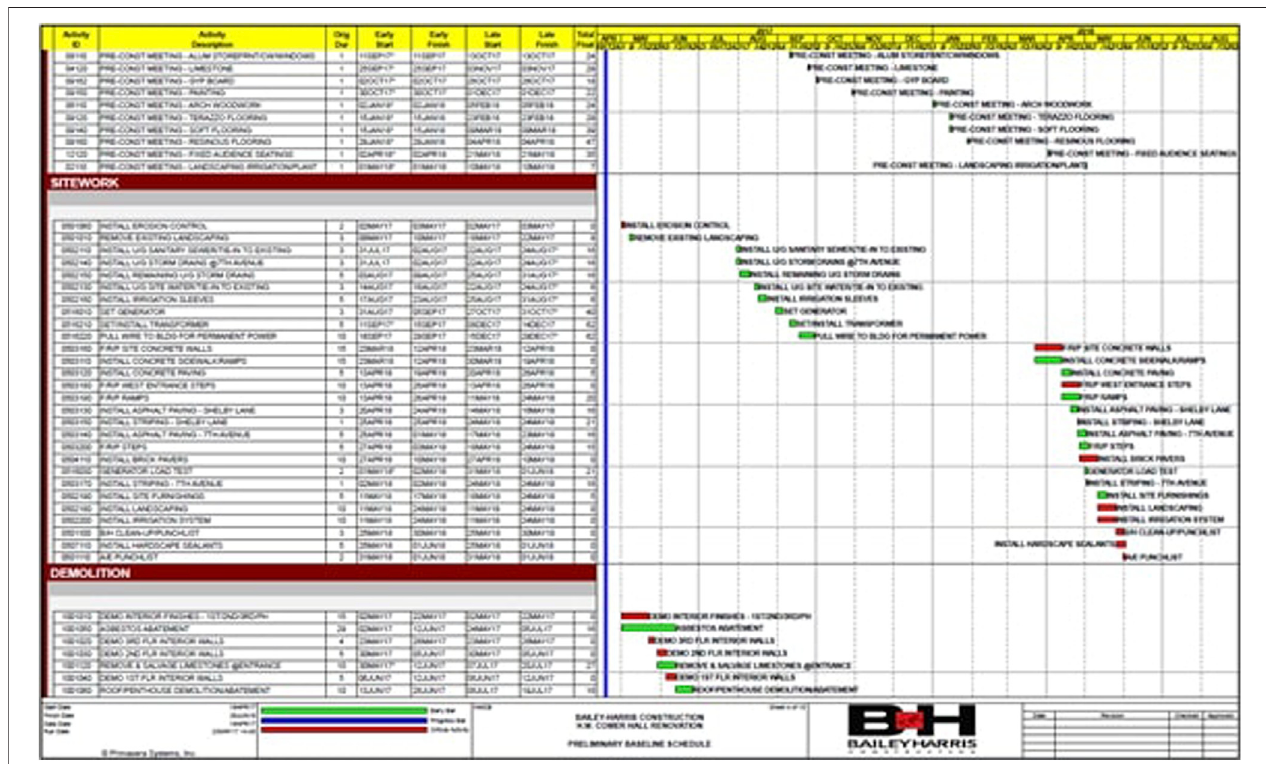
FIGURE 4 | Snapshot of Project Schedule for H.M. Comer Hall renovation in PDF format.